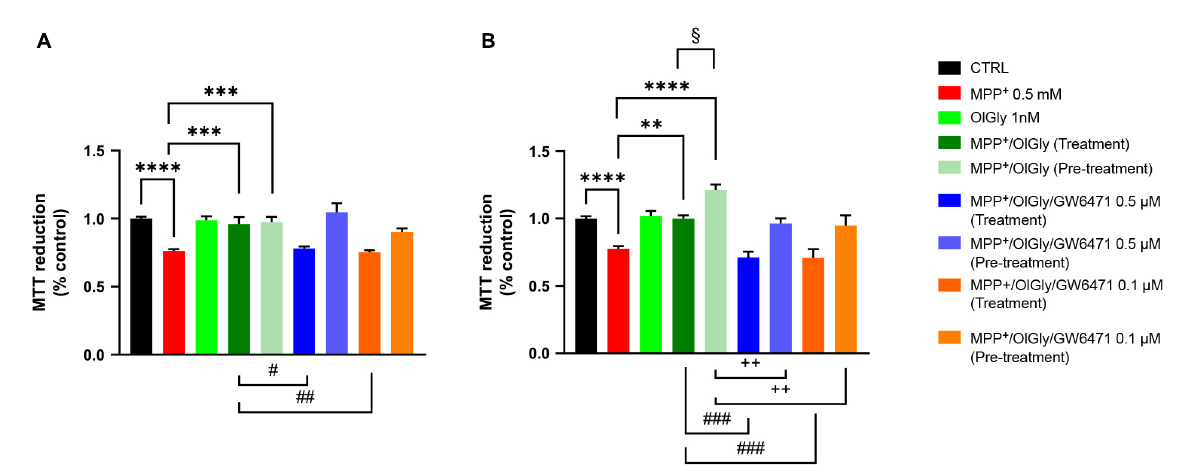
FIGURE3 Cell viability in (A) not differentiated and (B) differentiated SH-SY5Y cells measured with the MTT assay. Histograms represent the percentage, with respect to control cells (CTRL, 100%), of viable cells after the exposure to MPP + (0.5 mM), OlGly (1 nM), and GW 6471 (0.5 and 0.1 µ M) in both simultaneous treatment and pre-treatment experiments. Data are represented as mean ± SEM. ∗ Indicates values statistically significant vs. MPP + ; # indicates values statistically significant vs. MPP + /OlGly (simultaneous treatment); + indicates values statistically significant vs. MPP + /OlGly (pre-treatment); § indicates values statistically significant of MPP + /OlGly (simultaneous treatment) vs. MPP + /OlGly (pre-treatment). Student’s t -test was used for statistical analysis ( N = 6–12). ∗∗∗∗ Indicates values statistically significant with p < 0.0001; ∗∗∗ and ### indicates values statistically significant with p < 0.001; ∗∗ , ## , and ++ indicates values statistically significant with p < 0.01; ∗ , # , + , and § indicates values statistically significant with p <